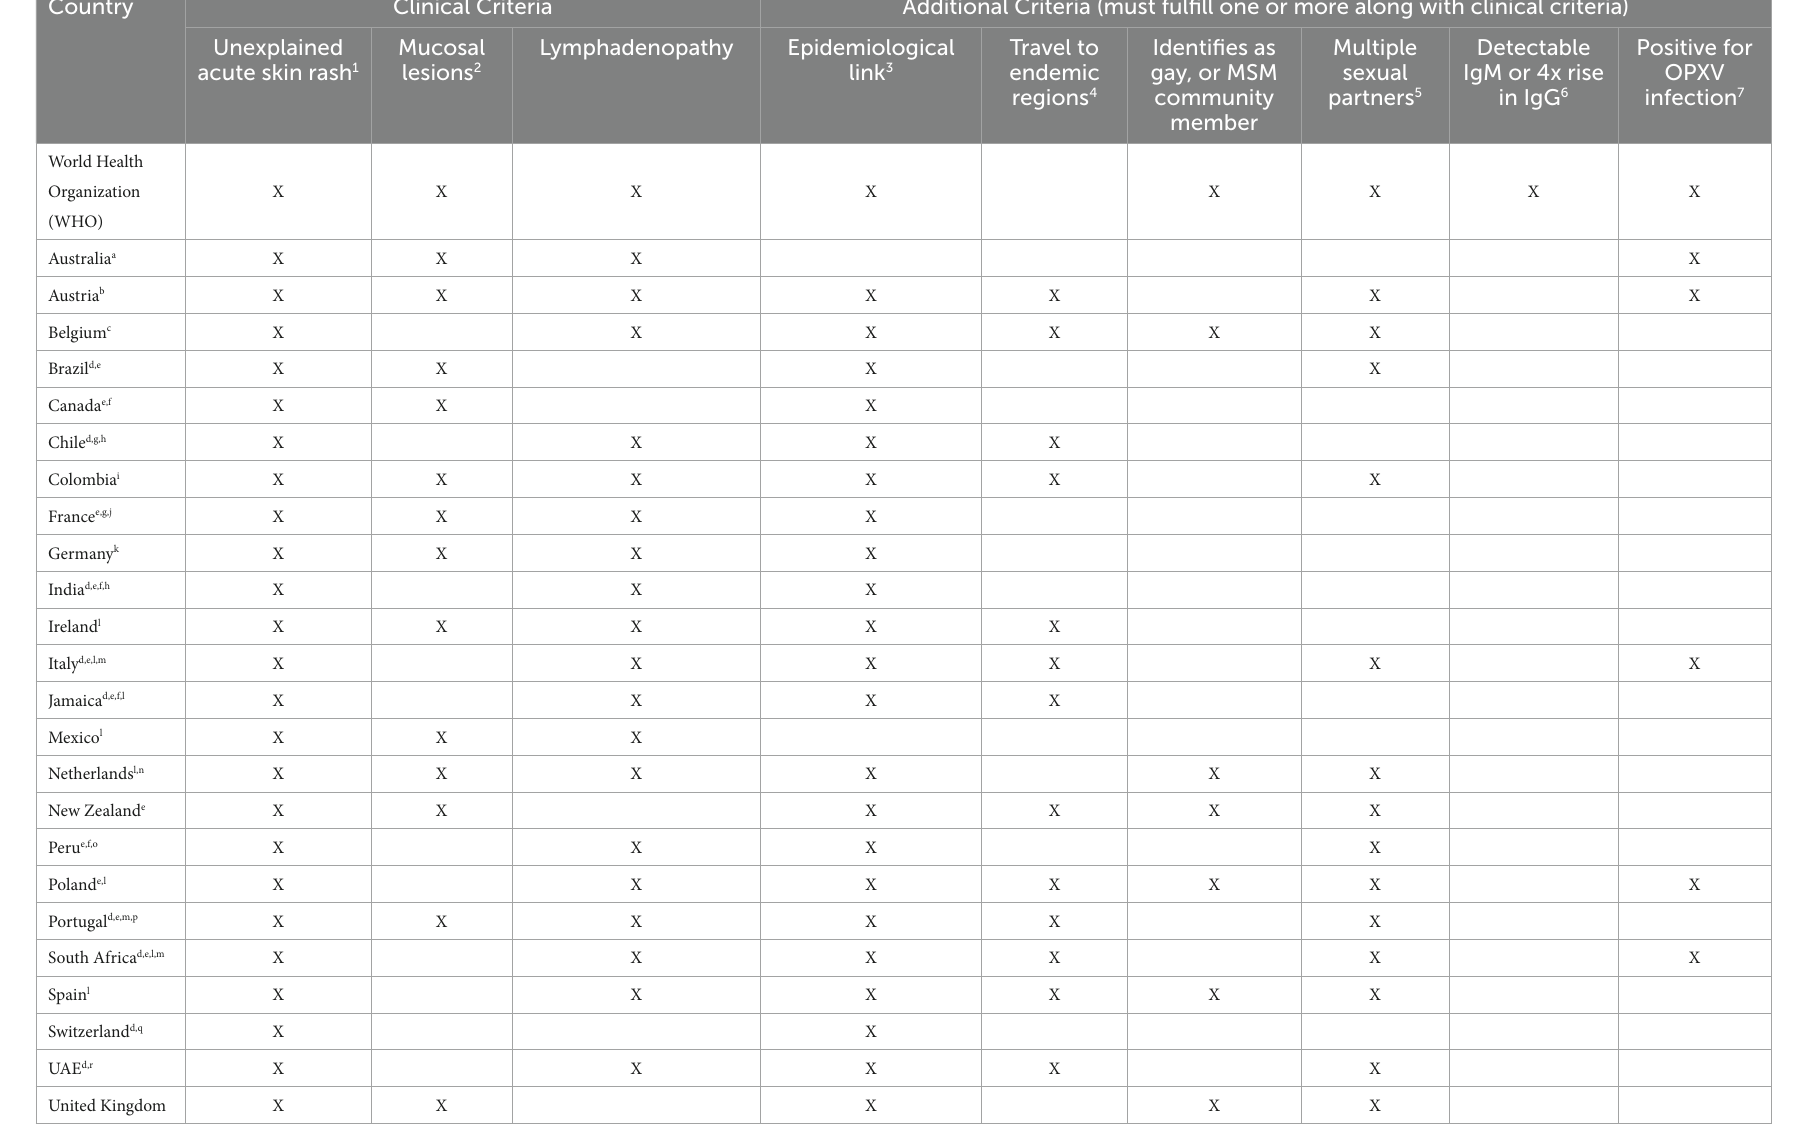
TABLE 2 Criteria for defining Mpox probable (or likely) case in the investigated countries.